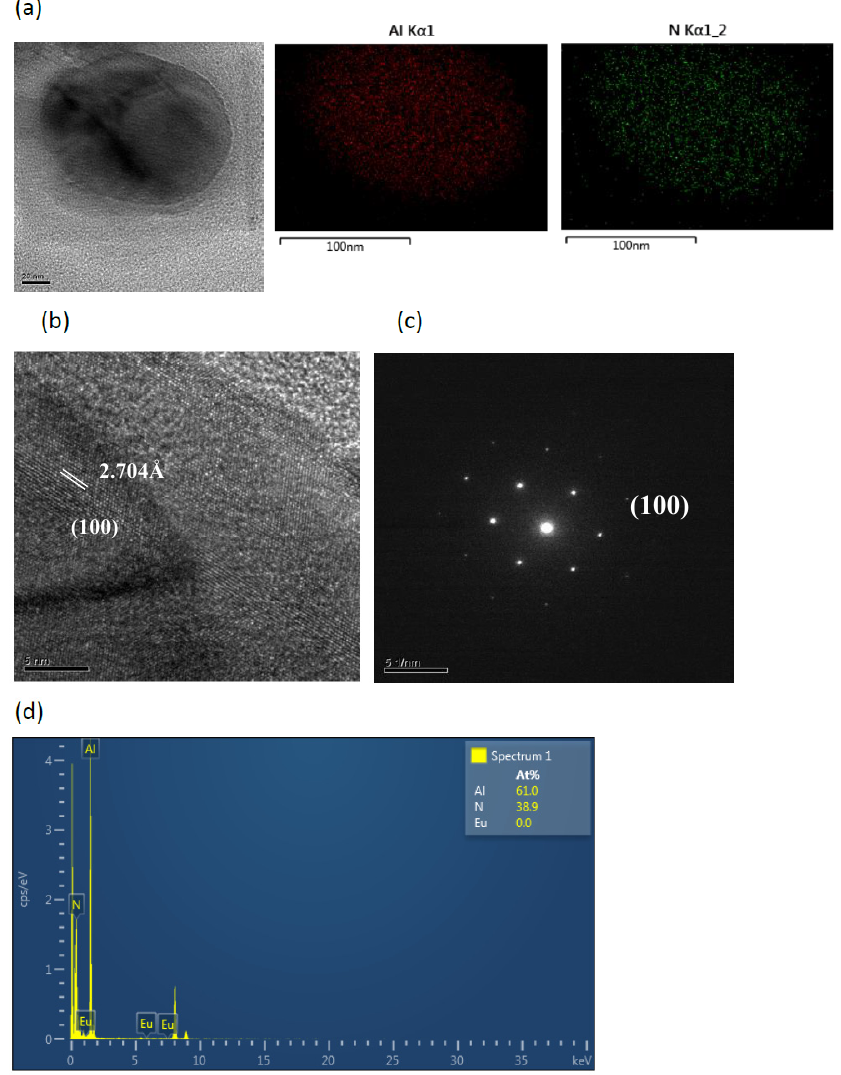
Figure 5. ( a ) TEM image and corresponding element mapping of Al and N; ( b ) HRTEM image; ( c ) SAED pattern; and ( d ) element analysis of a plate-like crystal (showing it to be AlN) in a product synthesized with Ca:Al:Si:Si 3 N 4 :Eu 2 O 3 :NaN 3 :NH 4 Cl = 1.0:1.0:0.25:0.25:0.02:3.5:0.6.